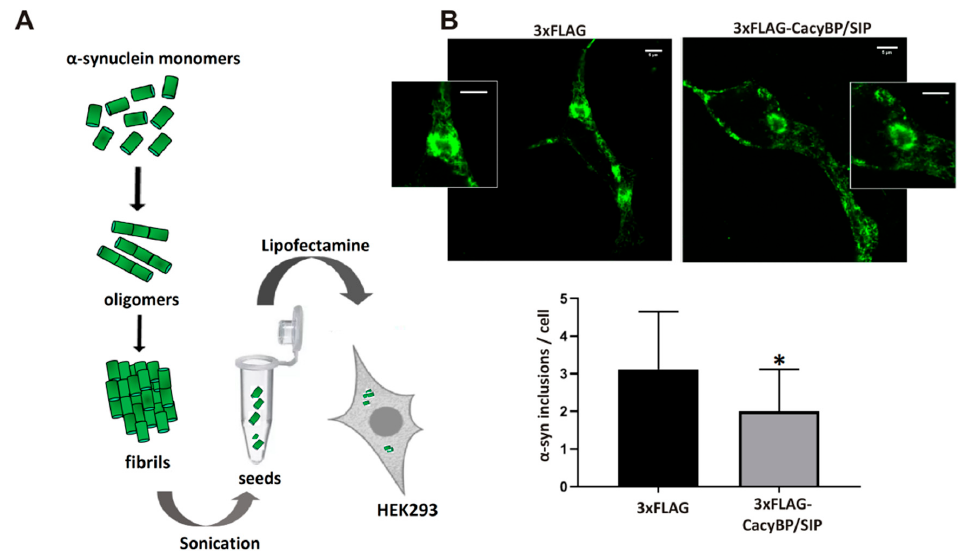
Figure 8. Influence of CacyBP / SIP on the number of α -synuclein aggregates in HEK293 cells. ( A ) A scheme showing preparation of α -synuclein seeds and their delivery to HEK293 cells. ( B, upper part ) Representative immunofluorescence staining performed with the use of primary conformation-specific anti- α -synuclein antibody. Aggregates / inclusions of α –synuclein are visible in green. Insert shows enlargement of inclusion. ( B, lower part ) Statistical analysis of the results